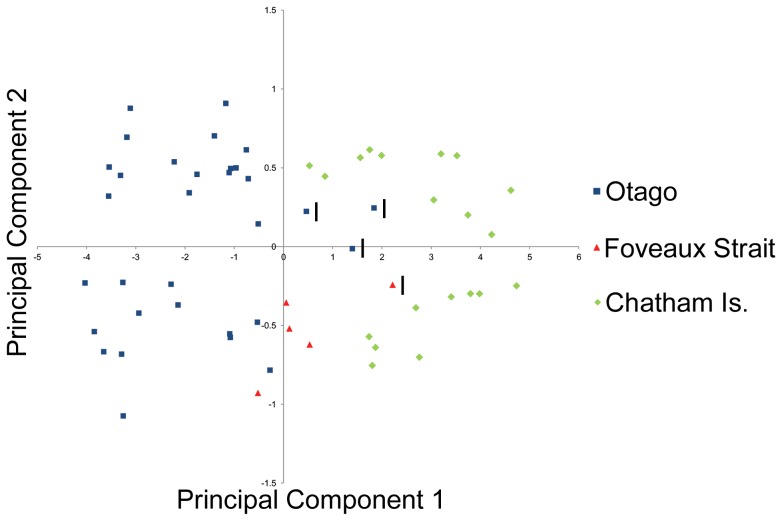
PCA cluster analysis of Leucocarbo chalconotus from southern New Zealand, and L. onslowi.The analysis was conducted on pooled element lengths (femur, tibiotarsus, tarsometatarsus, coracoid, humerus, ulna, and carpometacarpus). Immature birds are indicated with an ‘I’ on the figure.